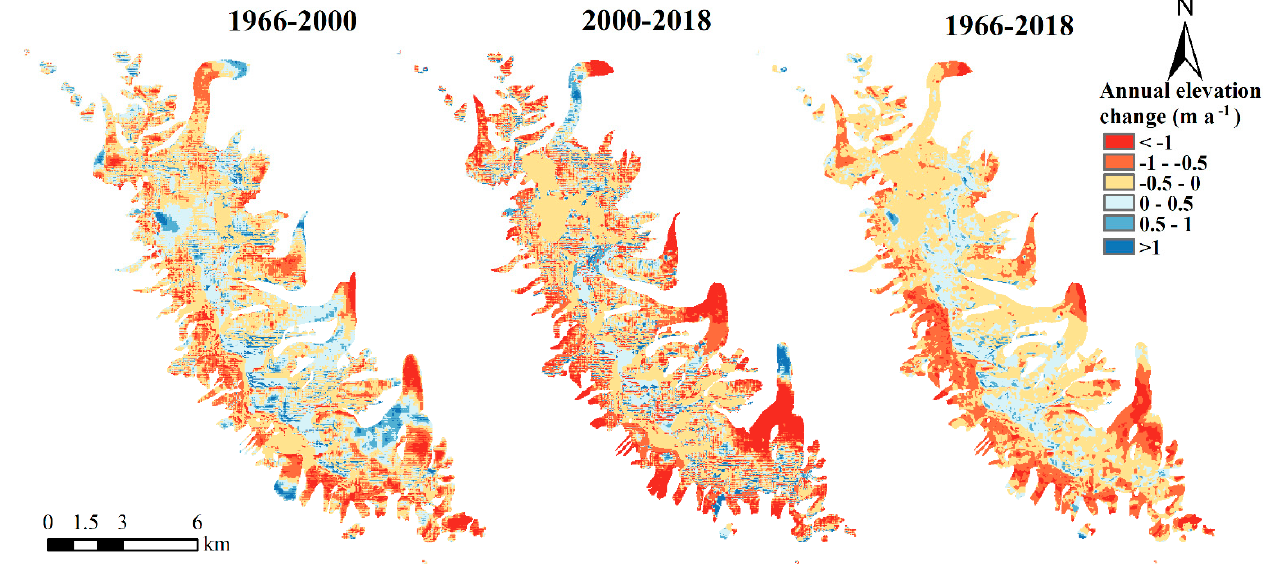
Figure 4. Surface elevation variations in glaciers over the A'nyêmaqên Mountains from 1966 to 2018.